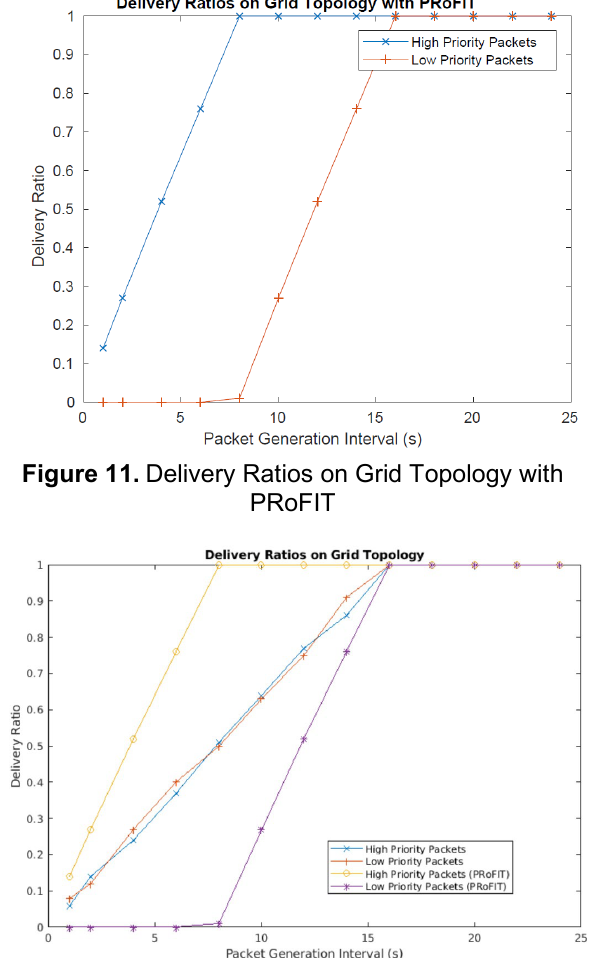
Figure 12 . Delivery Ratios on Grid